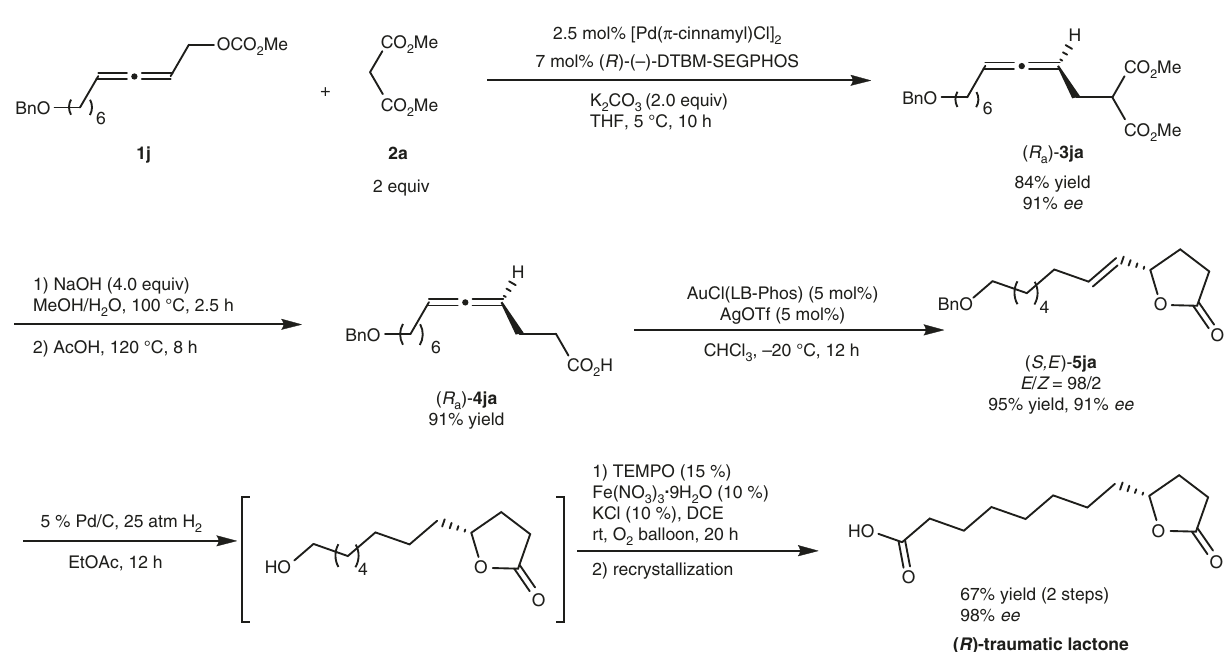
Fig. 4 The fi rst enantioselective synthesis of ( R )-traumatic lactone. Details of reagents, catalysts, solvent, and temperature are given in the reaction